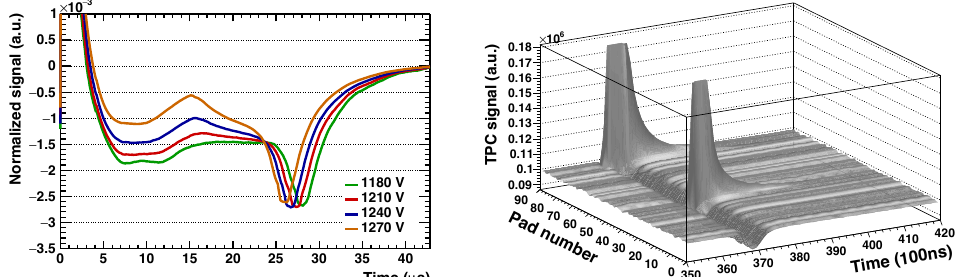
Figure 5. (Color online) Left: normalized pad signals with zoom into the y-axis showing the ion tail Fig. 9: (Color Online) Normalized pad signals with zoom into the y-axis for different anode voltage settings. (Left) Fig. 15: Integrated laser track signal on a given pad-row which illustrates the Common-mode effect. for different anode voltage settings. Right: laser track clusters (integrated over 2000 laser events) in a Ion-tail shape. (Right) Ratio of the undershoot to the pulse as a function of anode voltage. given pad-row illustrating the common-mode effect